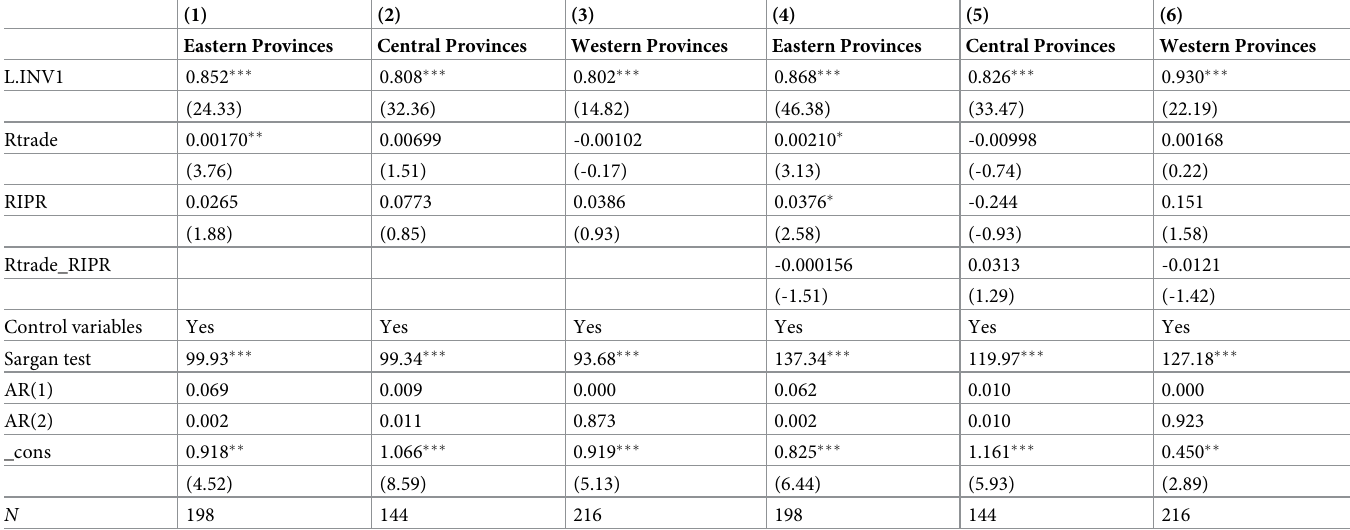
Table 7. System GMM estimates by region ( Rtrade ).